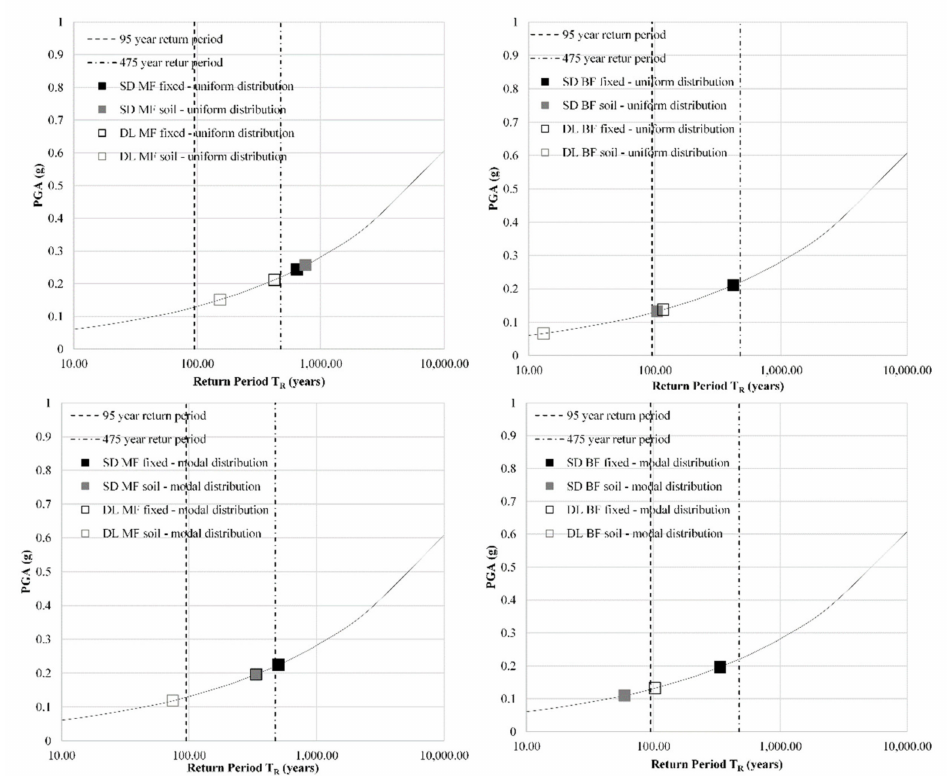
Figure 14. Performance levels in terms of PGA expressed as a function of T R